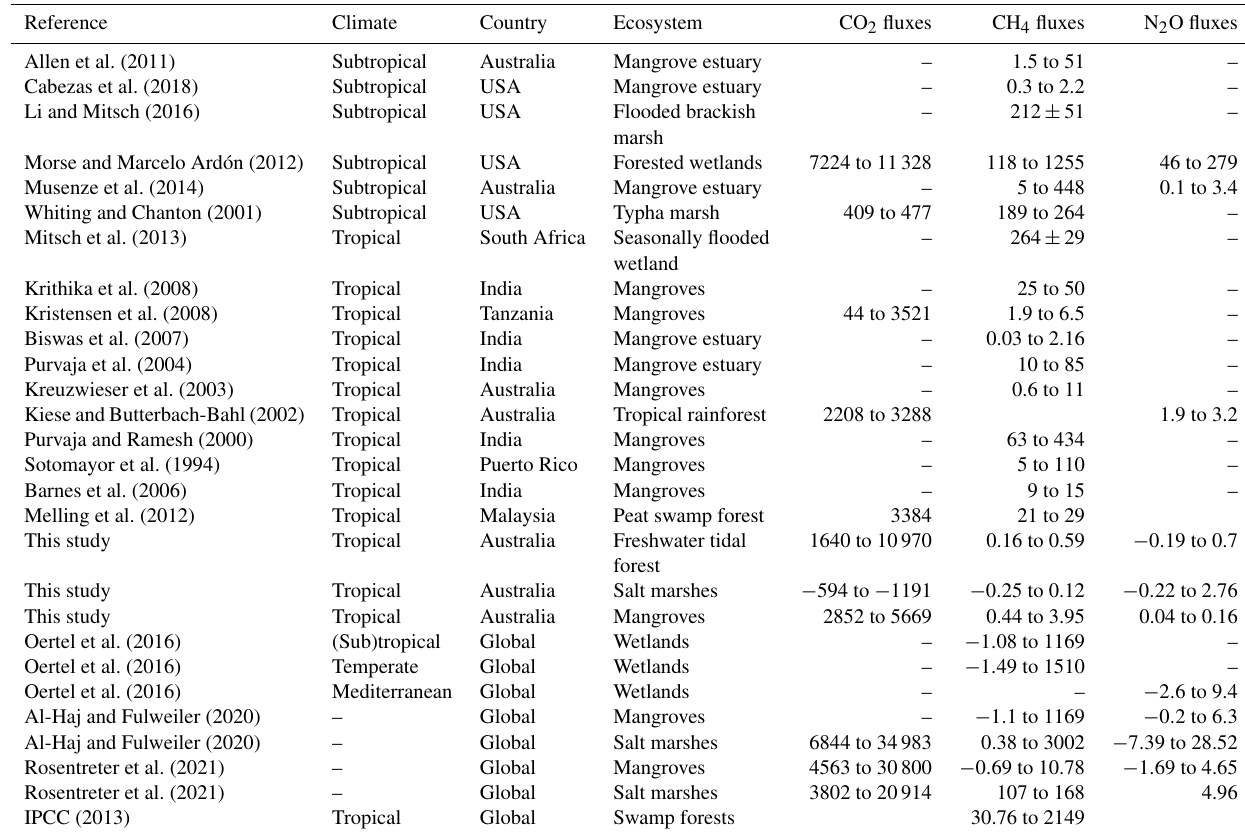
Table 3. Comparison of GHG fluxes (mgm − 2 d − 1 ) with other